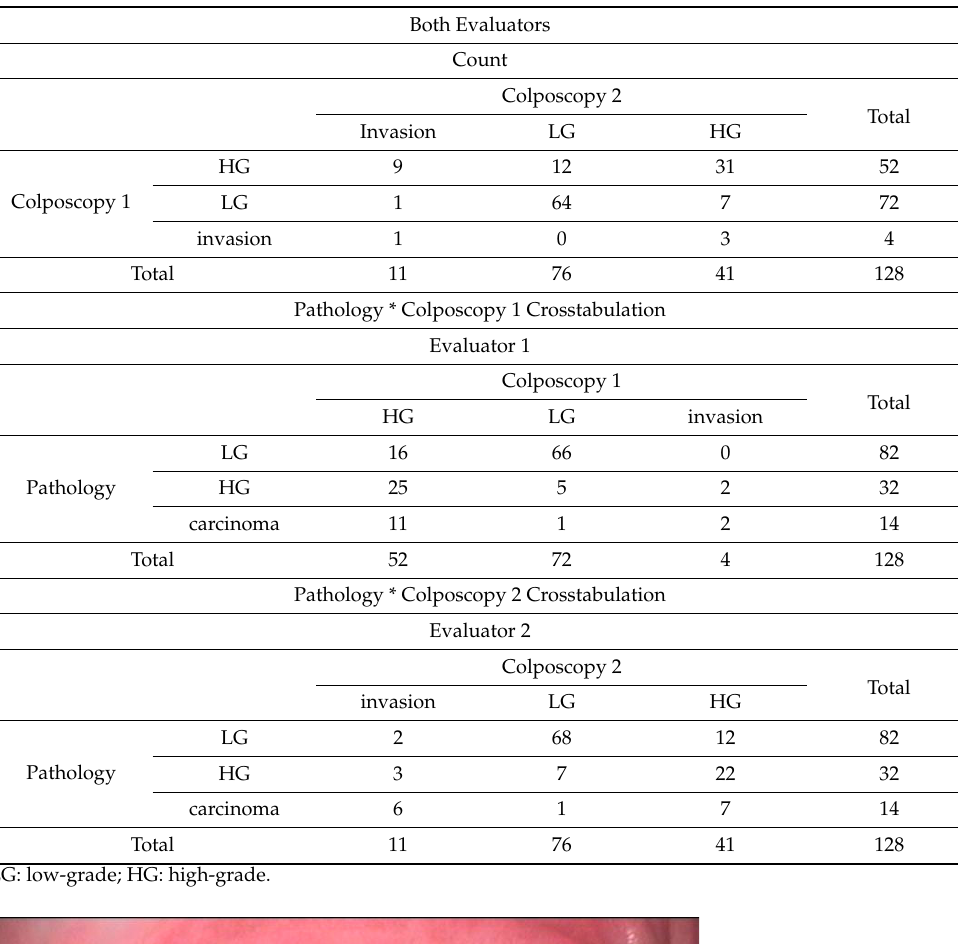
Table 2. Correspondence between the two colposcopic examiners.